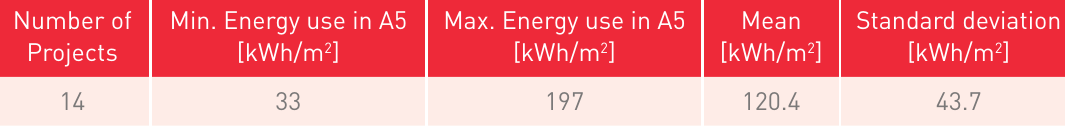
Table 5. Summary of EE in phase A5 obtained from the literature